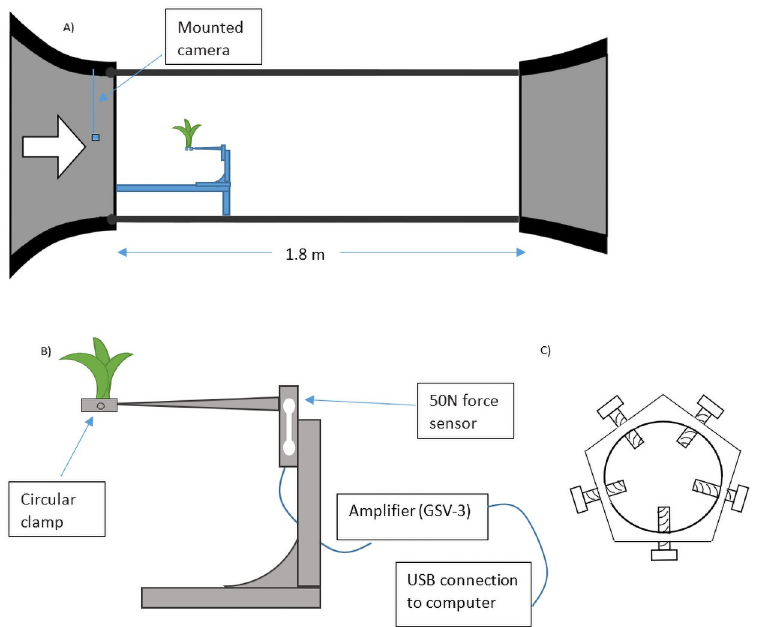
Fig 1. Wind tunnel setup and equipment used for drag force testing. (A) Wind tunnel setup. Each drag body is positioned in the middle of the wind tunnel. A small camera was mounted upstream to take frontal photographs of the drag body. (B) Diagram of setup used for testing drag force. Each plant was held in place with a circular clamp, and a scale bar was placed next to the screw on the clamp for measuring the size of the plant. Drag force was recorded with a 50 N double bending beam force sensor that was connected to a computer via an amplifier. (C) Diagram of the clamp ( Ø = 50 mm, Ø = 9 mm when all screws are fully screwed in) used to mount plant on the setup where screws are adjustable to fit different plant